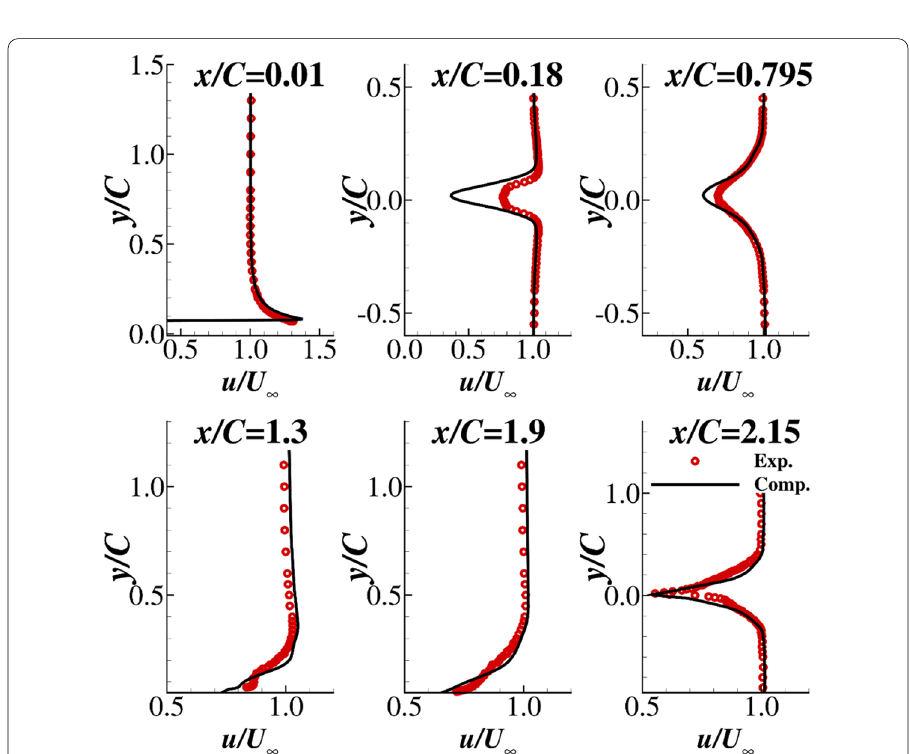
Fig. 14 Averaged streamwise velocity